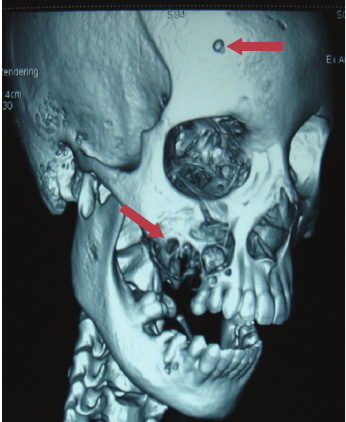
Figure 4: 3DCT showing erosion of walls of maxillary sinus with destruction of alveolar process and osteoporotic changes in frontal